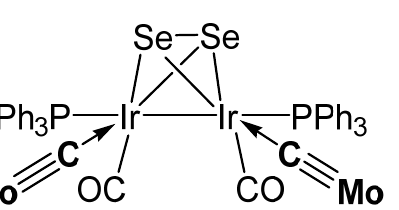
Figure 29. Selected structure of compounds with the [Mo] − C moiety.